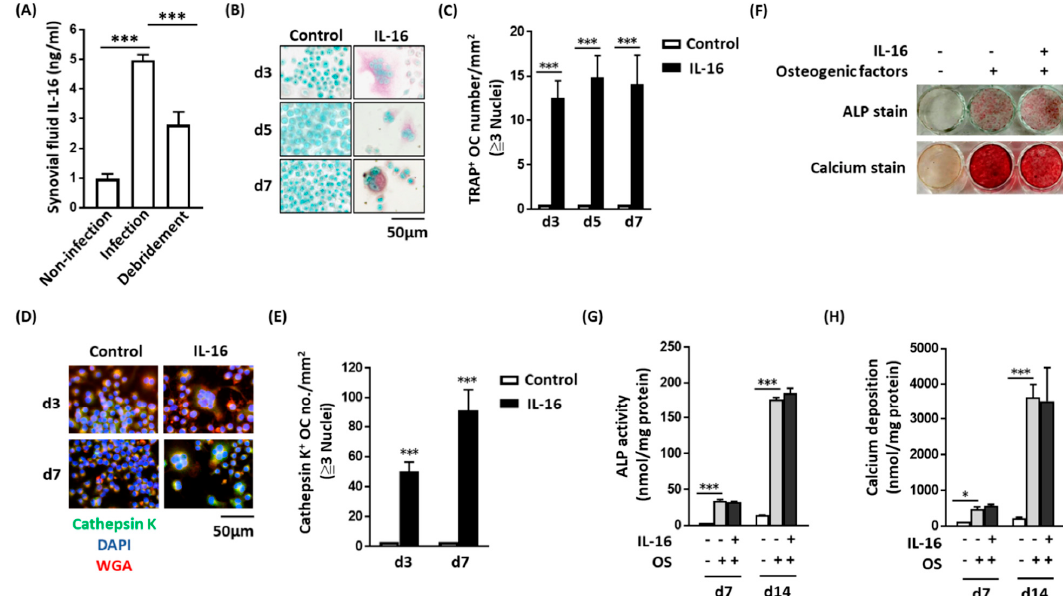
Figure 1. Synovial fluid interleukin-16 (IL-16) in patients with periprosthetic joint infection (PJI) contributed to osteoclast activation but osteoblast differentiation. ( A ) Synovial fluid IL-16 levels in patients with PJI ( n = 6) were higher than those in patients with aseptic loosening ( n = 27), the concentration of IL-16 decreased when patients received debridement surgery ( n = 11); ( B and C ) IL-16 promoted RAW264.7 cell differentiation into tartrate-resistant acid phosphatase-positive osteoclast-like cells; ( D and E ) IL-16 promoted RAW264.7 cell differentiation into cathepsin-K-positive osteoclast-like cells; ( F , G , and H ) IL-16 did not change the expression level of ALP or calcium during osteoblast differentiation. Data are presented as means ± standard errors of the mean.